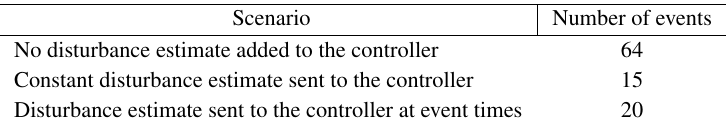
Table 5. Number of event times in different scenarios Scenario Number of events